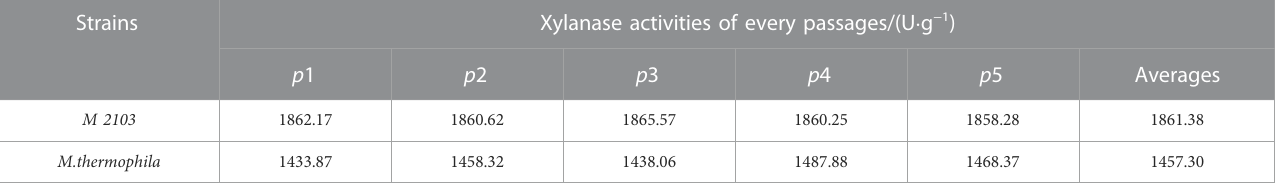
TABLE 1 Stability of xylanase activity of M 2103 and M.thermophila .